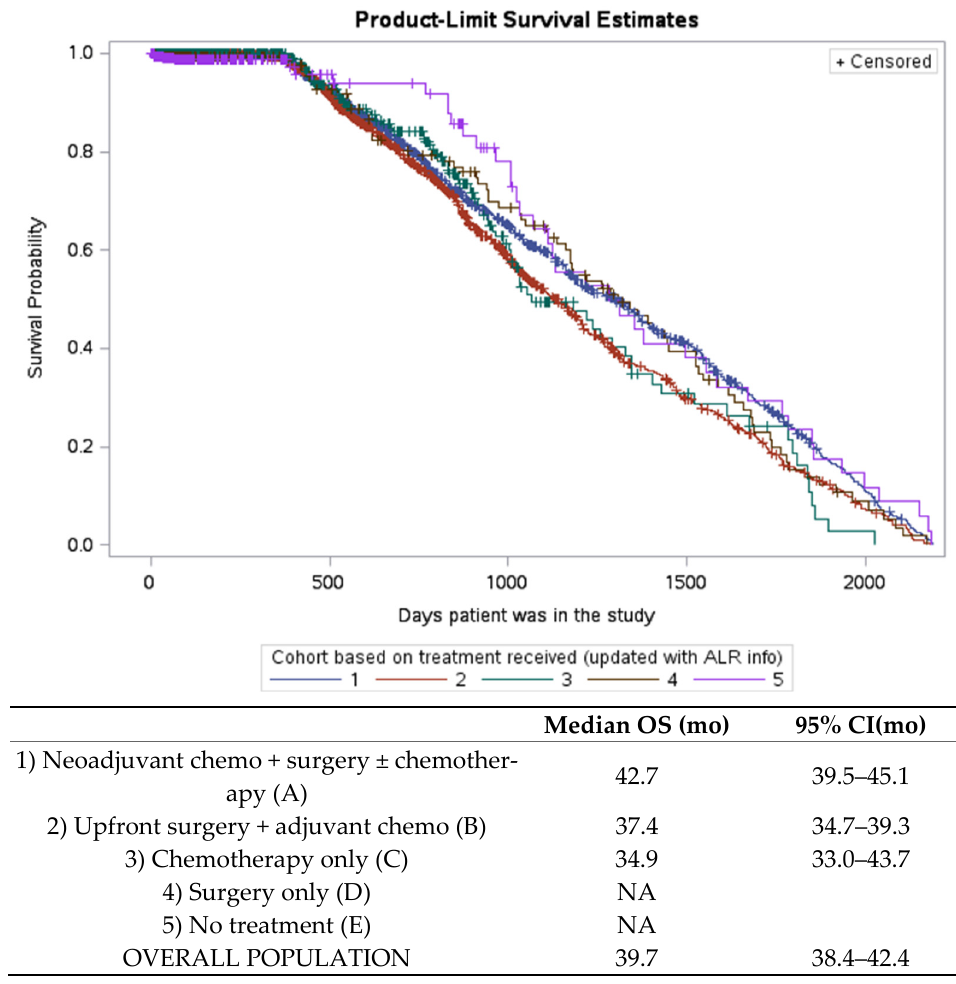
Figure 4. Kaplan–Meier survival analysis by treatment cohort. N/A-not assessed, given small numbers. OS-overall survival. 95% CI = 95% confidence interval. Mo-months. numbers. OS-overall survival. 95% CI = 95% confidence interval.